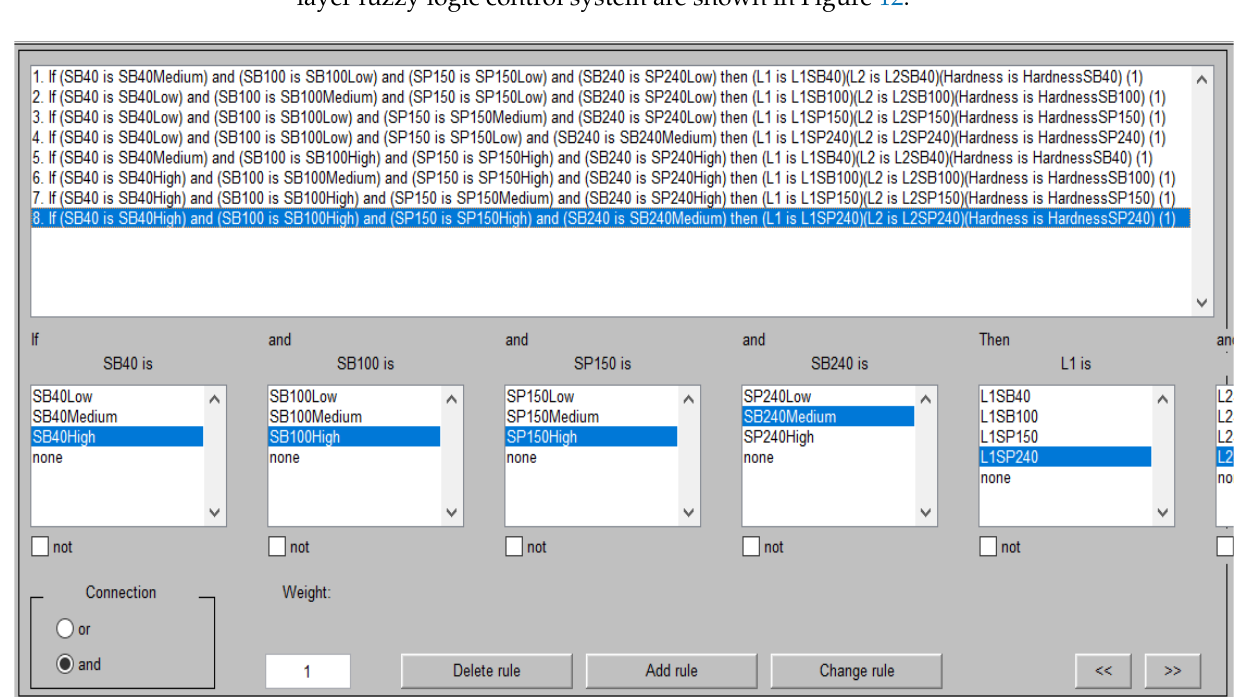
Figure 12. If-Then rules of geometry-hardness cladded layer fuzzy logic control system.